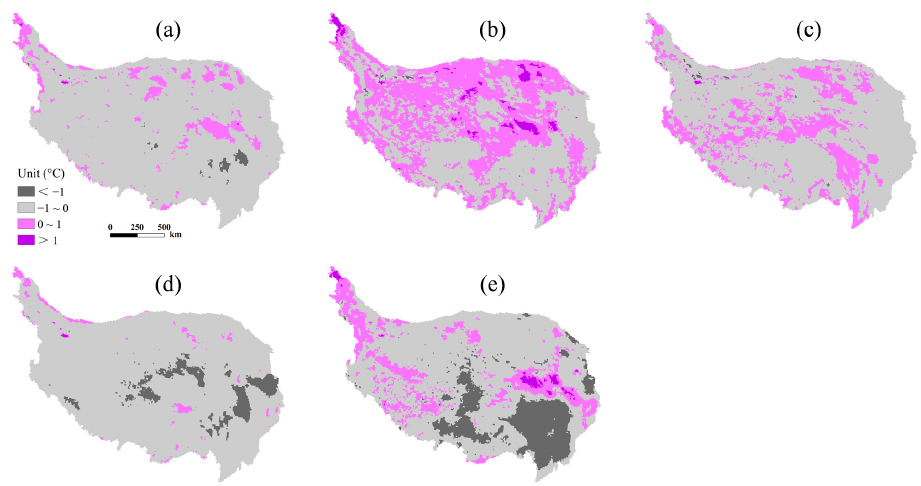
Figure 4. Spatial distributions of the difference in mean Δ T between 1986–2021 and 1950–1985 on the QTP; annual ( a ), spring ( b ), summer ( c ), autumn ( d ) and winter ( e ).